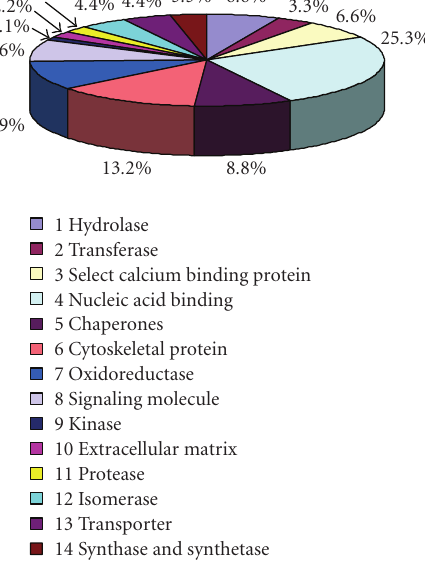
Figure 2: Pie chart showing the various functional categories as a percentage of the 91 di ff erentially expressed proteins based on the PANTHER classification